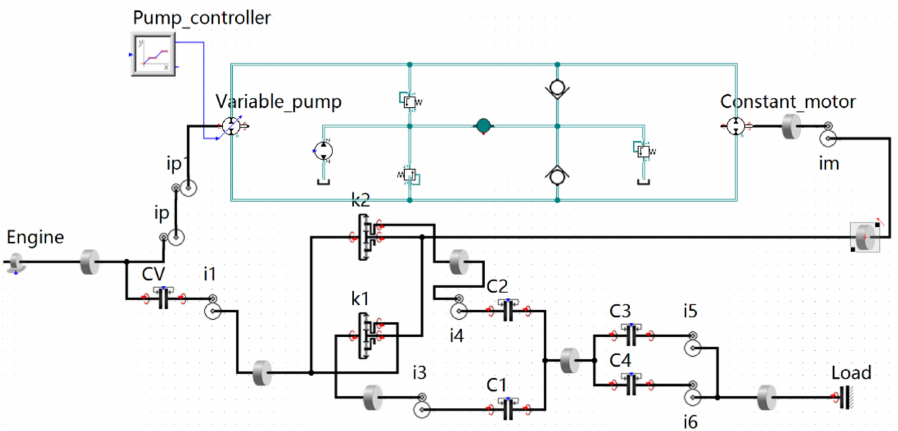
Figure 3. HMCVT efficiency characteristic simulation model based on Simulation